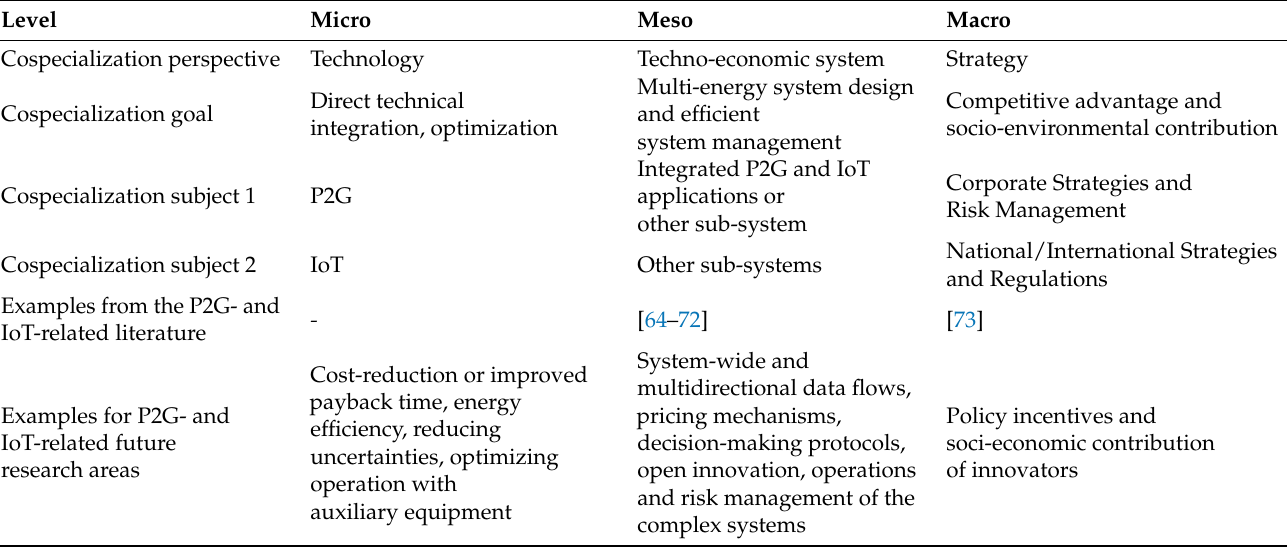
Table 4. Cospecialization aspects of P2G and IoT to support MES